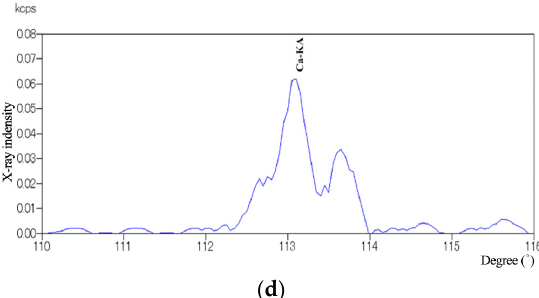
Figure 1. Fluorescence X-ray analysis diagram of A: ( a ) B-K α -K β ; ( b ) Mg-K α ; ( c ) O-K α ; ( d ) Ca-K α . As shown in Figure 1, the peaks of elements such as Mg, B, O, and Ca are clearly displayed, and the amount of added elements is clarified based on the peak intensity of each element. Table 3 is the analysis results by X-rays for all types of materials. Table 3. Composition analysis of powders by X-ray.